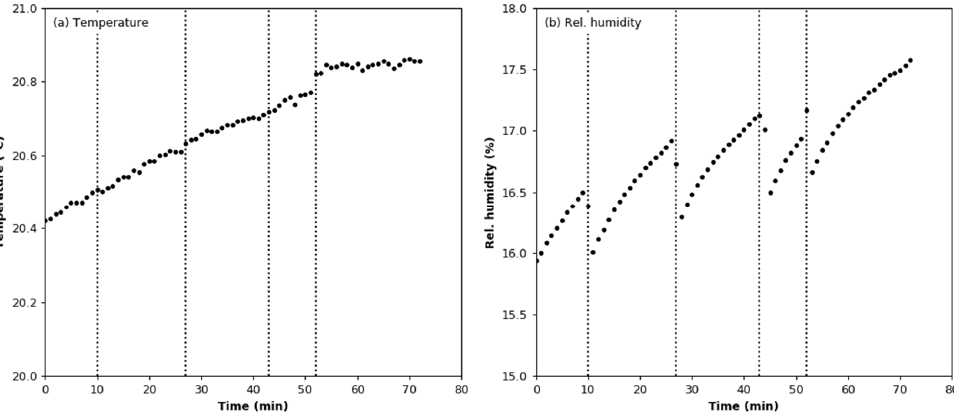
Figure 8. Environmental conditions during the argon effect test: ( a ) air temperature; ( b ) relative humidity.